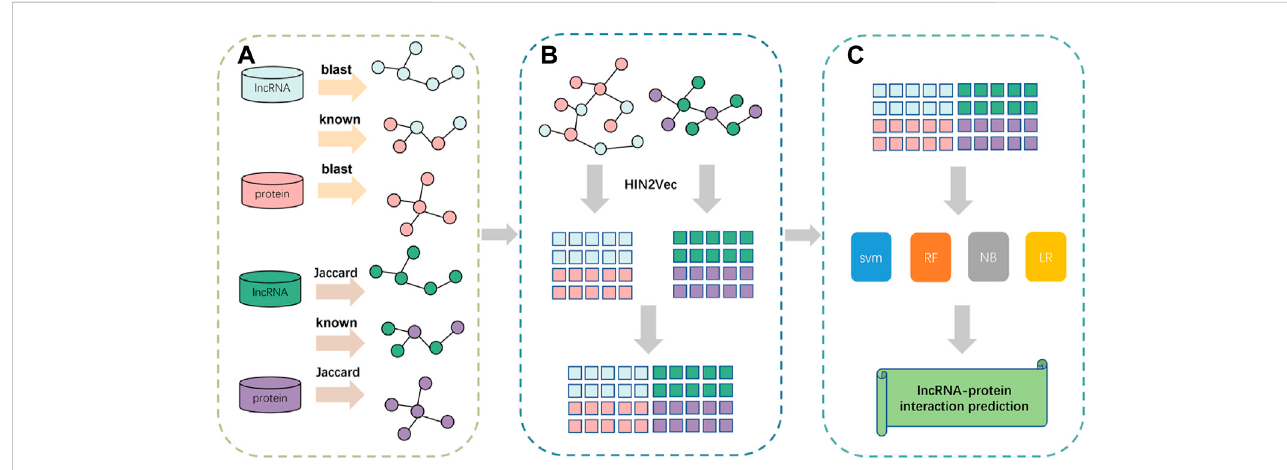
FIGURE 5 Pipeline of the framework of LPIH2V. (A) Calculation of similarity between lncRNA-lncRNA and protein-protein. (B) Construction of heterogeneous networks using similarity information obtained from (A) and extraction of node features using HIN2Vec. (C) Use of multiple classi fi ers to predict LPIs.